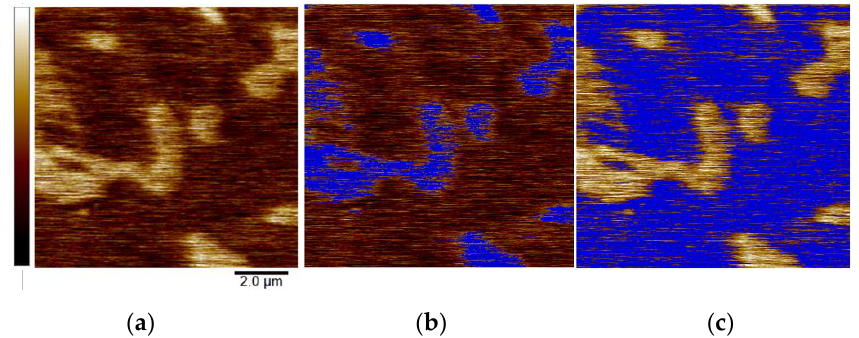
Figure 1. Representative 10 × 10 µ m 2 scanning Kelvin probe microscopy (SKPFM) images of P675- high-temperature temper (HTT). Dark brown corresponds to the softer matrix phase, which is lower in height following polishing than the harder, lighter brown carbides. Images show ( a ) the original Volta potential image (600 mV full-scale range) and subsequent implementation of thresholding cutoffs (blue) to calculate average Volta potential differences (VPDs) for the ( b ) matrix and ( c ) carbides.